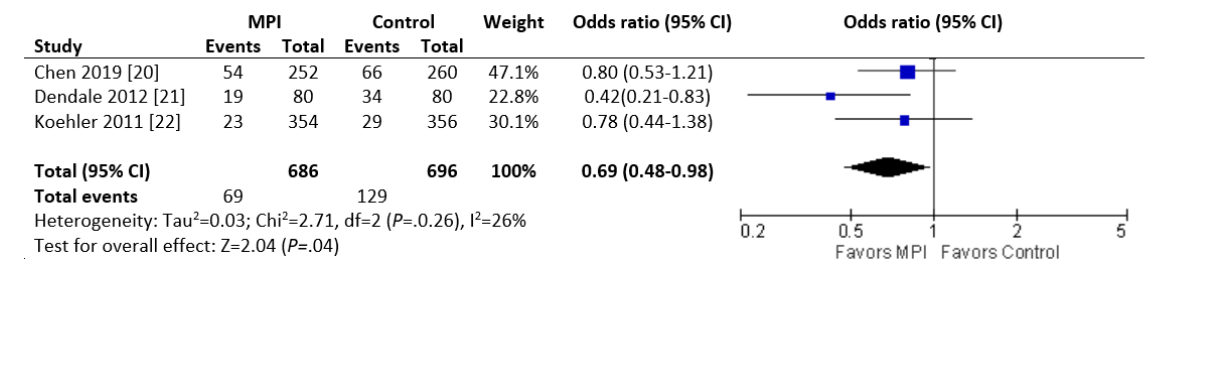
Figure 3. Forest plot of the odds ratio (OR) of heart failure readmissions in patients with heart failure who were involved in randomized controlled trials comparing a mobile phone intervention versus control. The estimate of the OR of each trial corresponds to the middle of the squares, and the horizontal line shows the 95% CI. The summary OR is represented by the middle of the solid diamond. A test of heterogeneity is given below the summary statistics. MPI: mobile phone intervention, df: degrees of